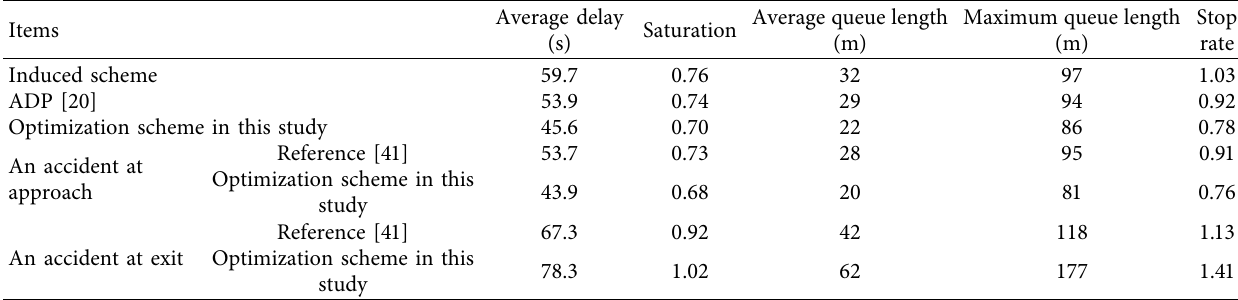
Table 9: Comparison of various signal control